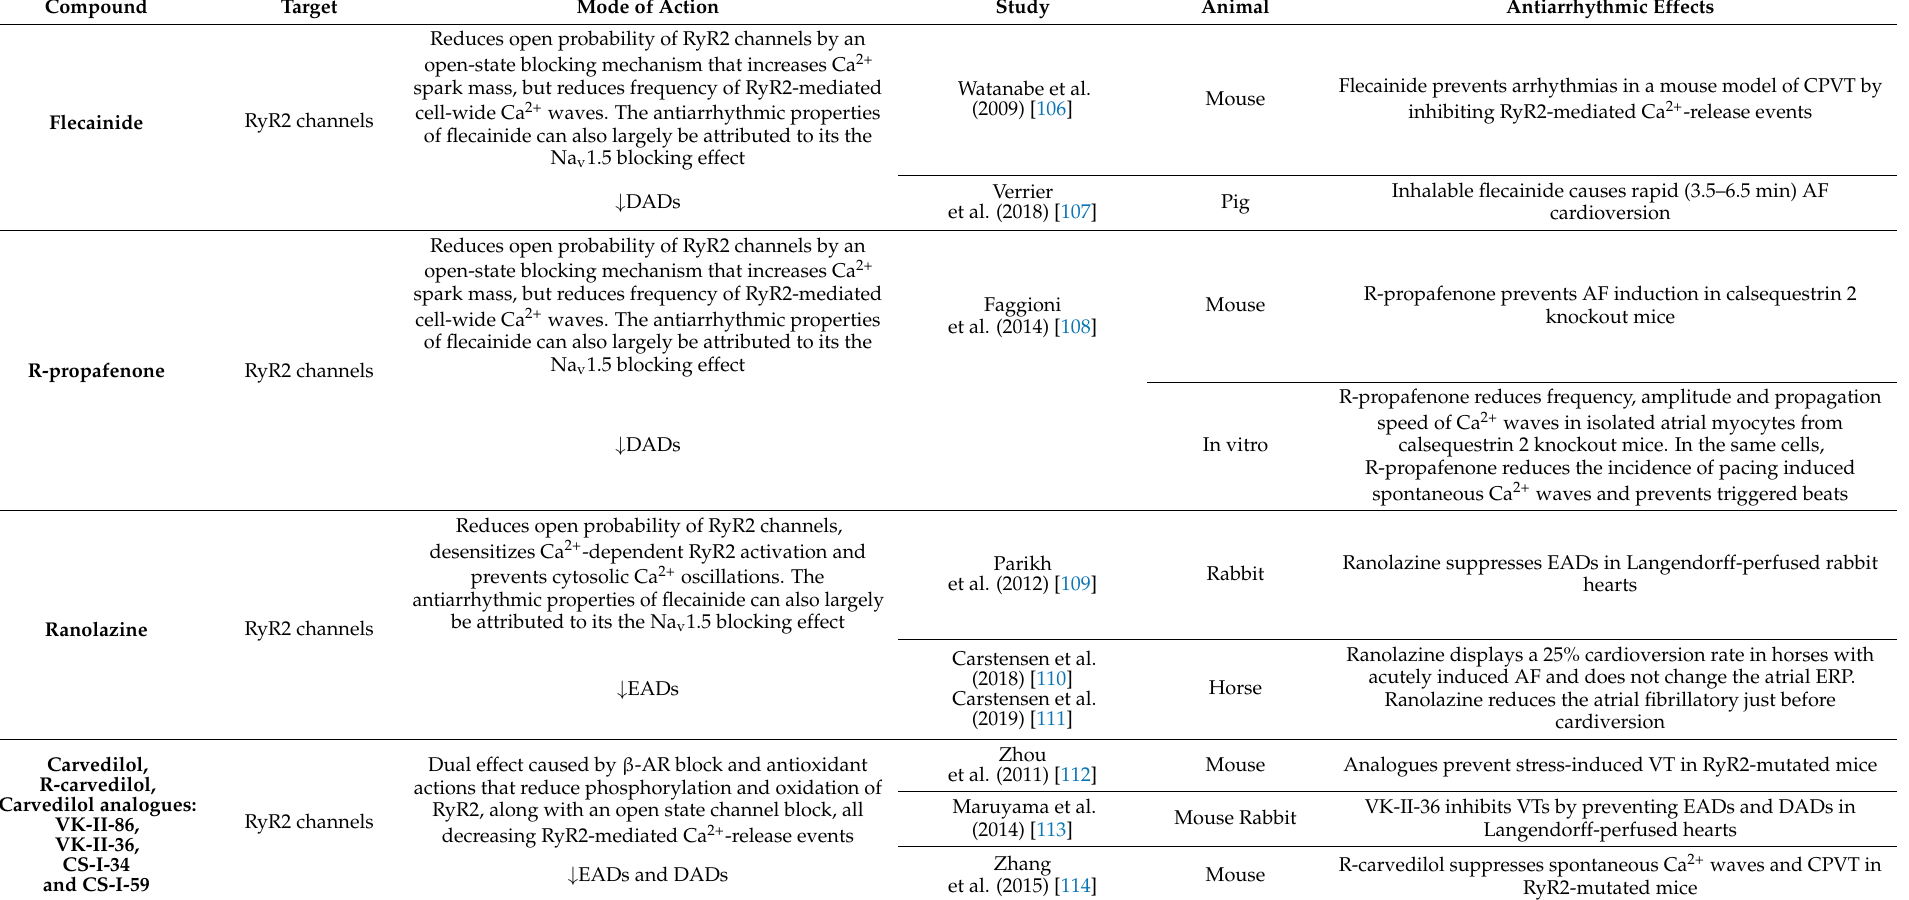
Table 1. Experimental evidence of antiarrhythmic efficacy of emerging drugs for atrial